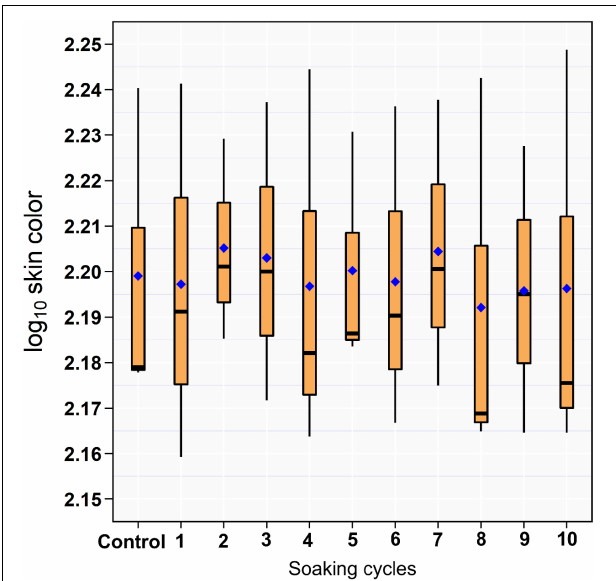
FIGURE 2 | Box and whiskers plot of log 10 RGB of the drumstick skin color across the 10 sequential soaking cycles.